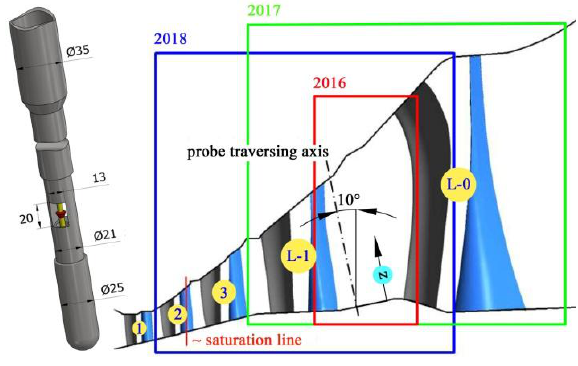
Fig. 1. The placement of the probe in the LP turbine The right side of Figure 1 schematically shows a probe traversing axis in a 5 stage LP part of 1000 MW ST with the measurement plane inclined ~10° from the radial plane. For data collection, the head of the extinction probe can be manually or automatically traversed to the desired position z along the blade